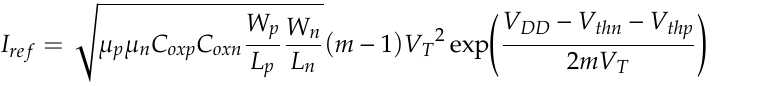
Figure 7. Quasi-static D-Flip Flop.